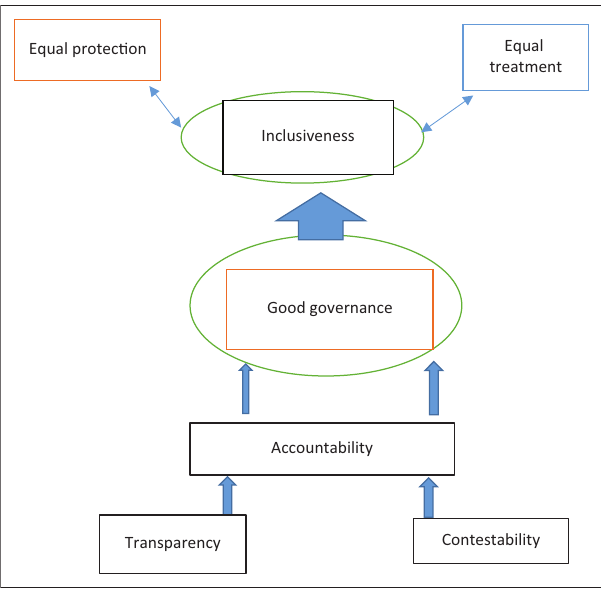
FIGURE 1: Dynamics of good governance in